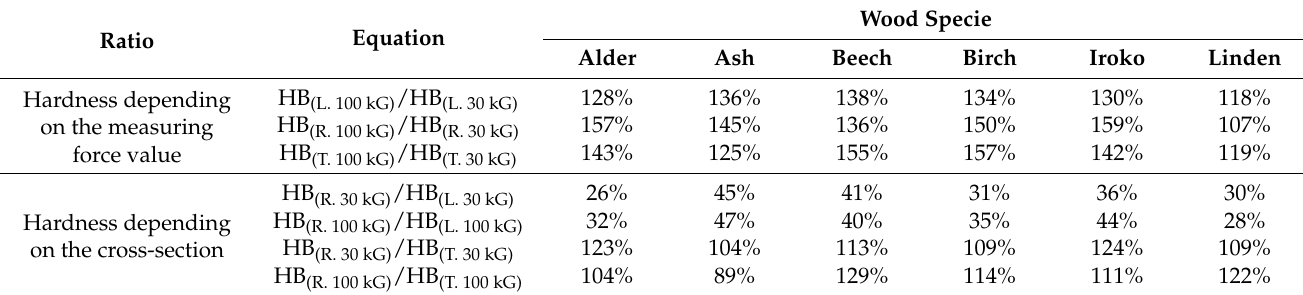
Table 2. HB values ratios. Three main cross-sections of wood (R, T, and L) and two measuring